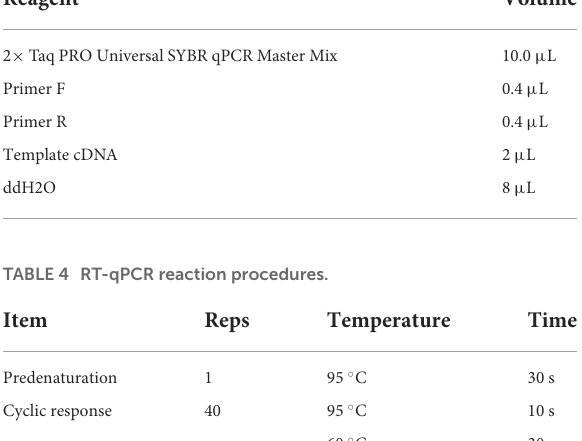
TABLE 3 RT-qPCR reaction system details.